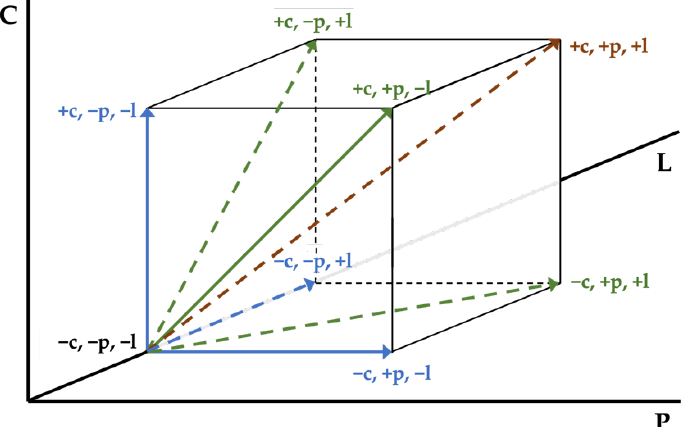
Figure 1. Variation of a single factor (blue), of two factors (green), and of three factors (brown) between the low value ( − ) and the high value (+). P, C, and L are represented in the axis X, Y, and Z, respectively. P corresponds to the application of a plasma treatment; C means post-curing was performed in the composites; L refers to the reinforcement length.